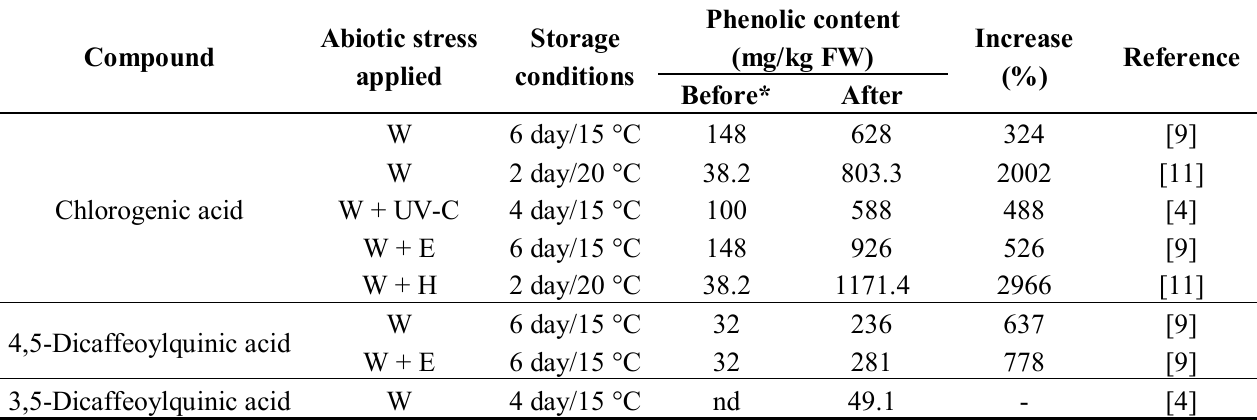
Table 1. Effect of different abiotic stresses (wounding, UV-light, ethylene, and hyperoxia) on the accumulation of individual phenolic compounds in